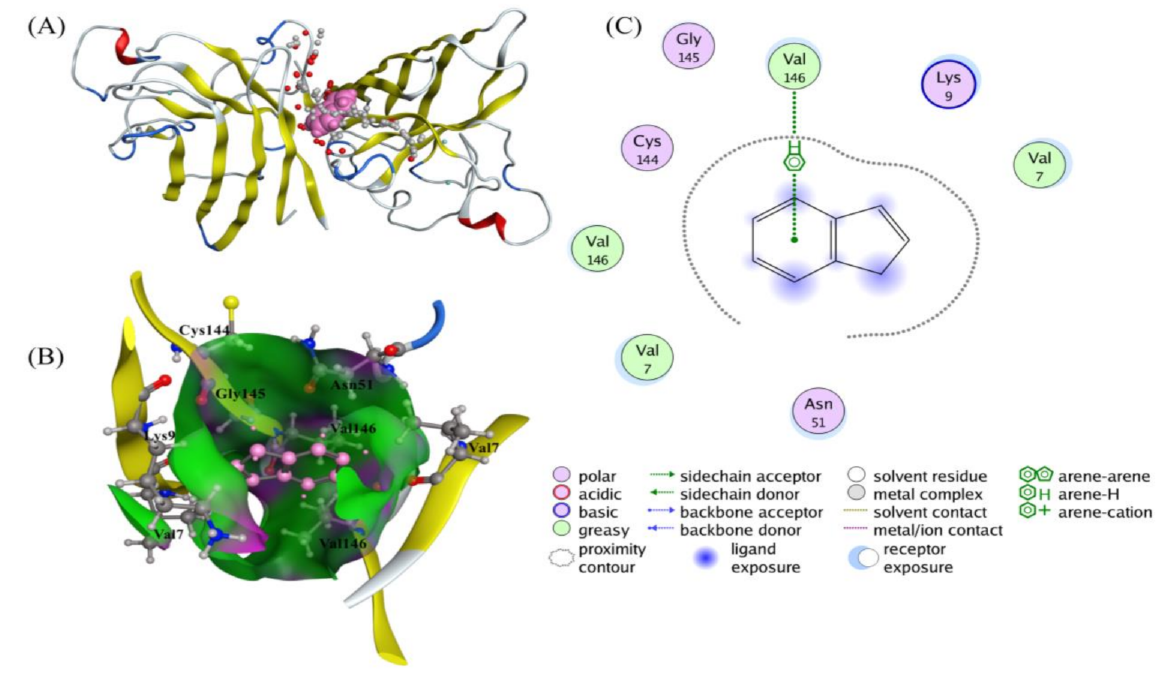
Figure 7. IND and SOD docking configuration files. ( A ) SOD is represented by cartoon, IND is represented by ball and stick, and active site is represented by filling mode. ( B ) Gaussian contact pattern superposed with ligand and receptor: pink for hydrogen bonding, green for hydrophobic preference, blue for mild polarity. IND is represented by sticks, and related amino acid residues are represented by balls and sticks. ( C ) Ligand interactions between IND and related amino acid